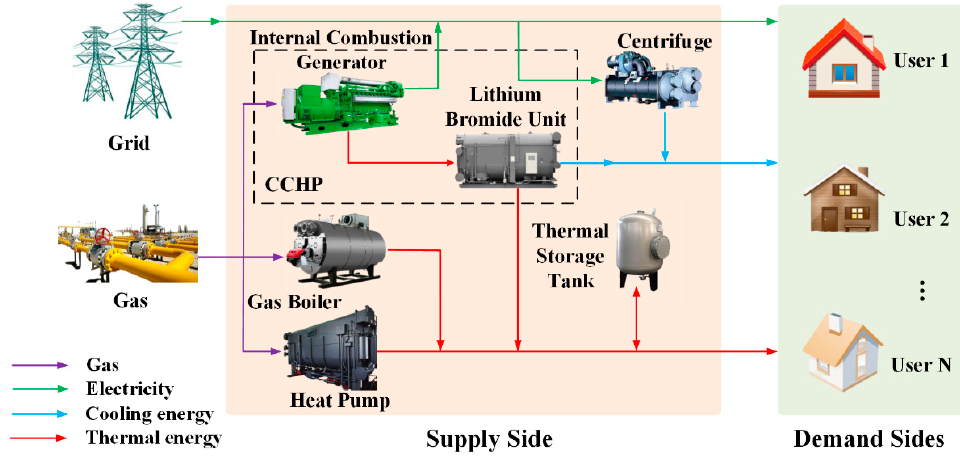
Figure 3. The structure of MES.